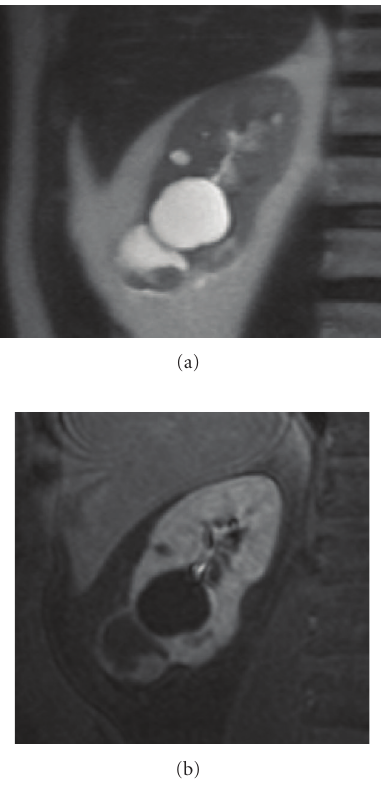
Figure 16: (a) Coronal haste T2 and (b) late postcontrast coronal T1 with fat saturation. Cystic lesion with an enhancing nodule on the caudal aspect of the kidney. Renal cell carcinoma was found at